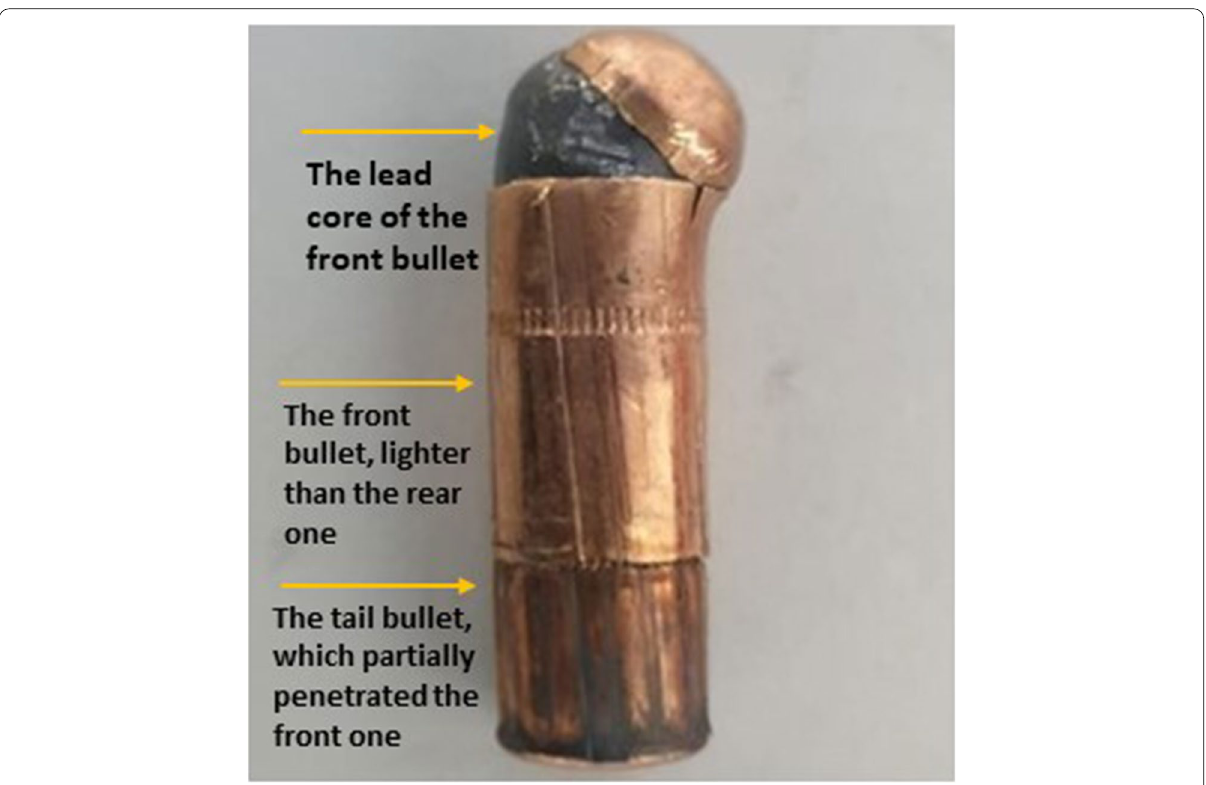
Fig. 1 The tandem bullets, merged together and extracted from the subject’s thigh. Note the chromatic difference between the front bullet and the back one, which is darker than the